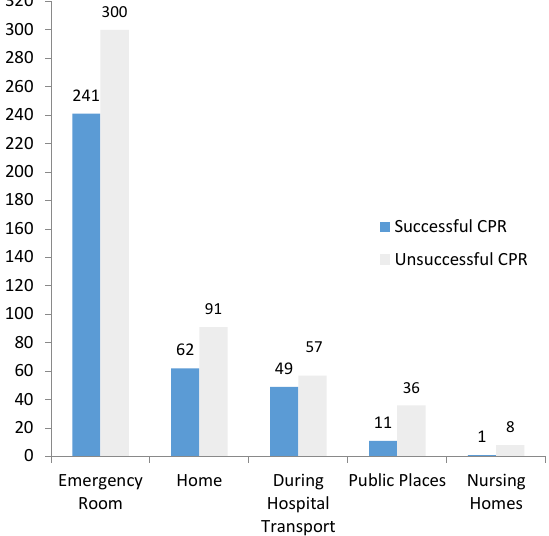
Figure 2. The number of successful and unsuccessful CPR regarding place of cardiac